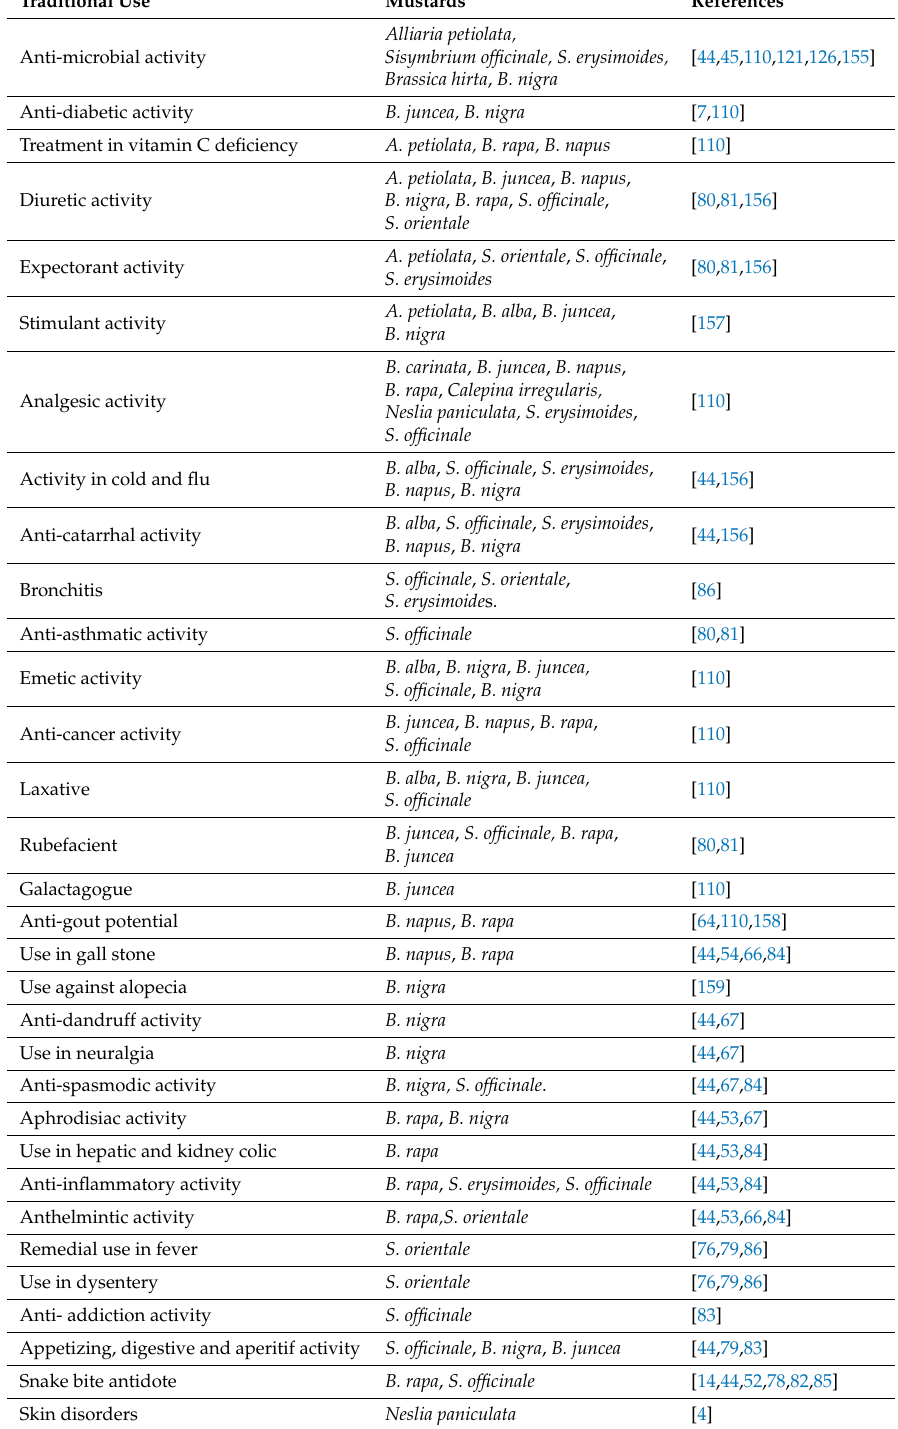
Table 3. Traditional/folkloric use of mustard